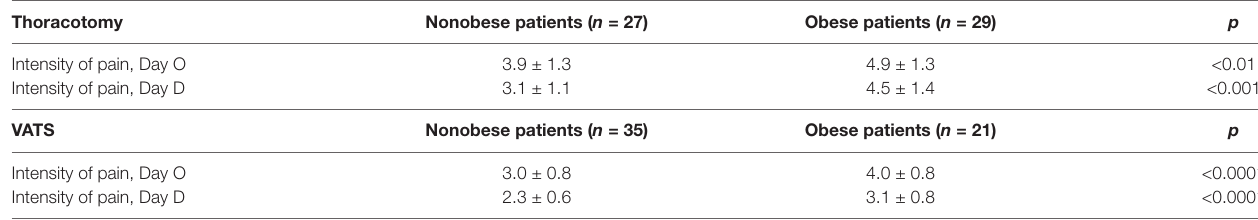
TABLE 4 | The intensity of pain comparison in the groups of obese and nonobese lung cancer patients who underwent thoracotomy and VATS.